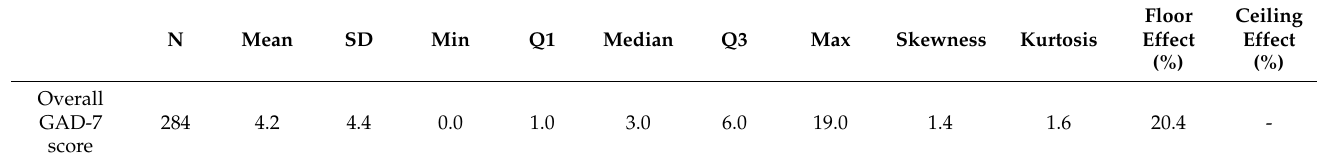
Table 4. Overall GAD-7 scores (N =